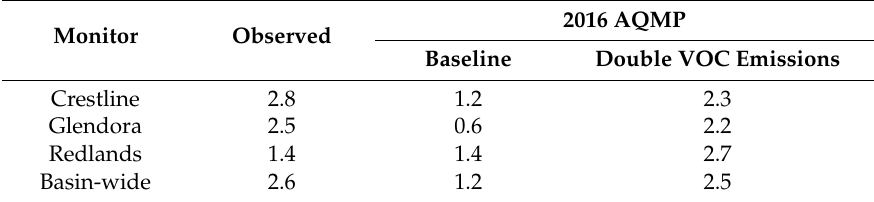
Table 4. 2016 AQMP ozone reduction rates (ppb/year) in 3 year ozone design values for the 2008-2015 period for the baseline case and for VOC emissions sensitivity